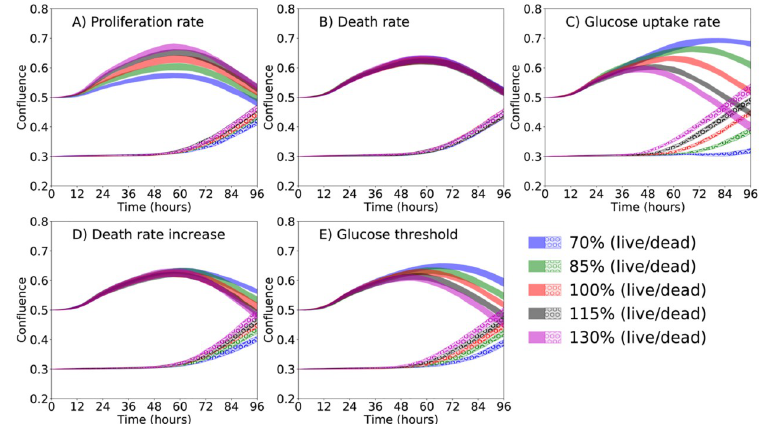
Fig 7. Parameter sweep. Effect of proliferation rate ( � a ; panel A), death rate ( � a ; panel B), glucose uptake ( λ ; panel C), P D death rate increase due to lack of glucose ( γ D ; panel D), and glucose threshold ( σ H ; panel E) for live and dead cell phenotypes. The live cells are seeded with 0.5 confluence, and the dead cells with 0.3 confluence. The base value of the parameters are the ones shown in Table 1 (from the deterministic values column). We changed one parameter at a time by 15% (reducing or increasing up to 30%). According to Panel A, the live and dead cell confluences are directly proportional to the proliferation rate. In Panels B, C, D, and E (i.e., for the death rate, glucose uptake, death rate increase due to lack of glucose, and glucose threshold, respectively), the live cell confluence is inversely proportional to the parameters being tested, while the dead cell confluence is directly